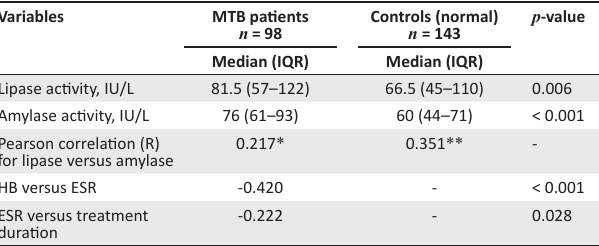
TABLE 1 : Comparison of lipase and amylase activity levels in patients with tuberculosis versus normal controls. Variables